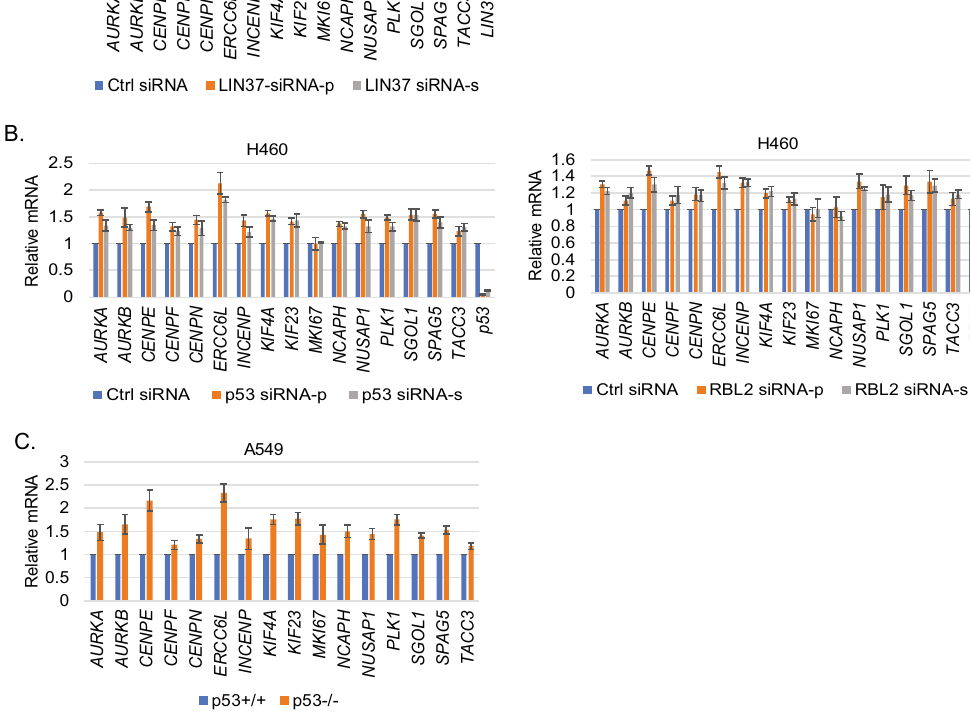
Figure 3. Depletion of p53/RBL2/LIN37 increases expression of the AURKA/B pathway genes. ( A , B ) H1666, H2030, H460 were transfected with control siRNA, RBL2 siRNA (pooled and single), p53 siRNA (pooled and single), or LIN37 siRNA (pooled and single) for 24 h and then analyzed for gene expression by qPCR. ( C ) p53+/+ and p53−/− cells were analyzed the indicated gene expression. Average relative mRNA (three independent experiments, one sample each) of the indicated genes are presented with SD indicated. Statistical analyses are shown in Supplementary Table